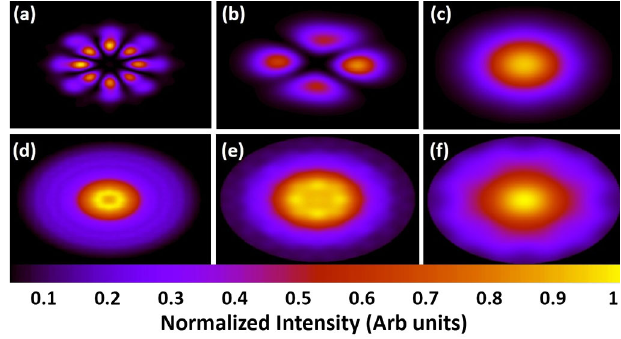
FIG. 9. Mode profiles from the simulations with an outcoupling hole size of 4 mm, for the intermediate configuration ( g ¼ − 0 . 6 ) at wavelengths of (a) 10 μ m, (b) 25 μ m and (c) 50 μ m, and for the concentric configuration ( g ¼ − 1 ) at wavelengths of (d) 10 μ m, (e) 25 μ m and (f) 50 μ m. For each plot the window size is 50 mm by 50 mm.